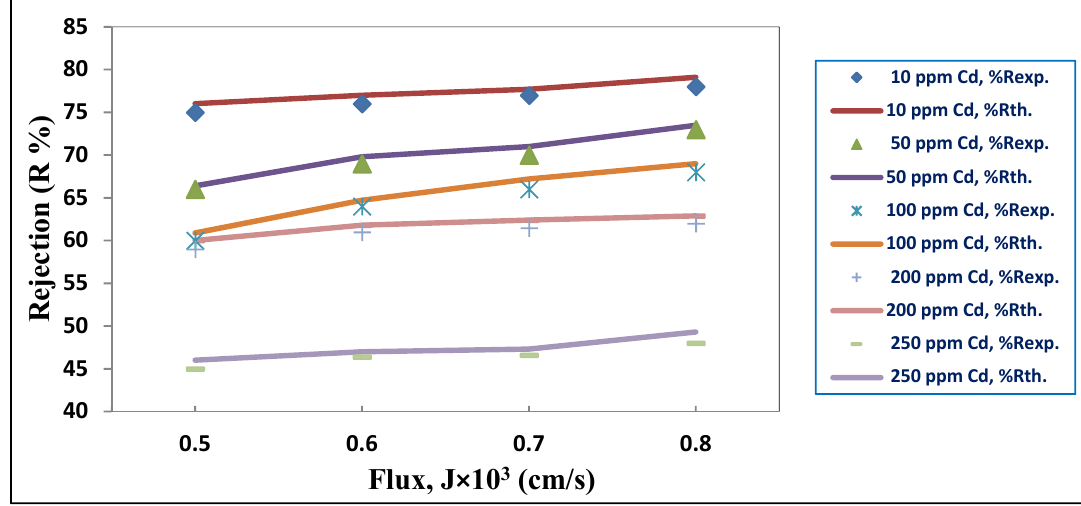
Figure 12. Results of CFFP model for the dataset of the PES1 membrane for Cd (NO 3 ) 2.